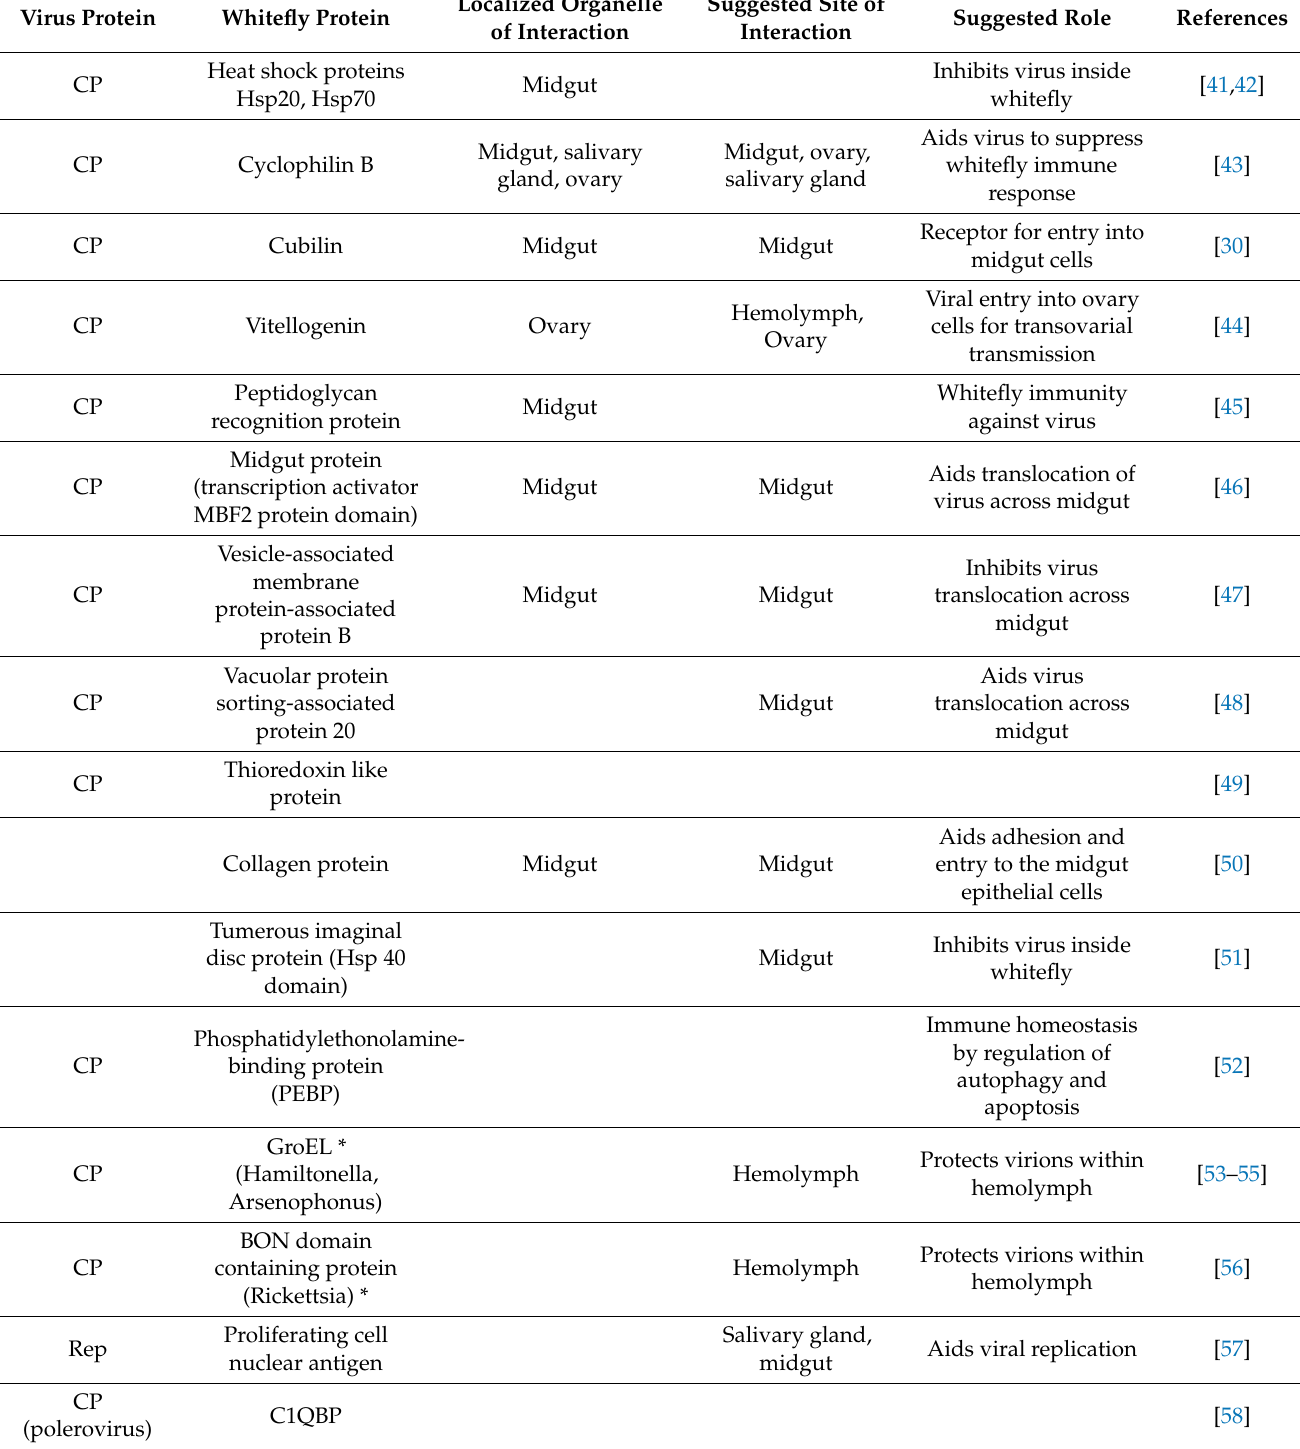
* B. tabaci endosymbiont